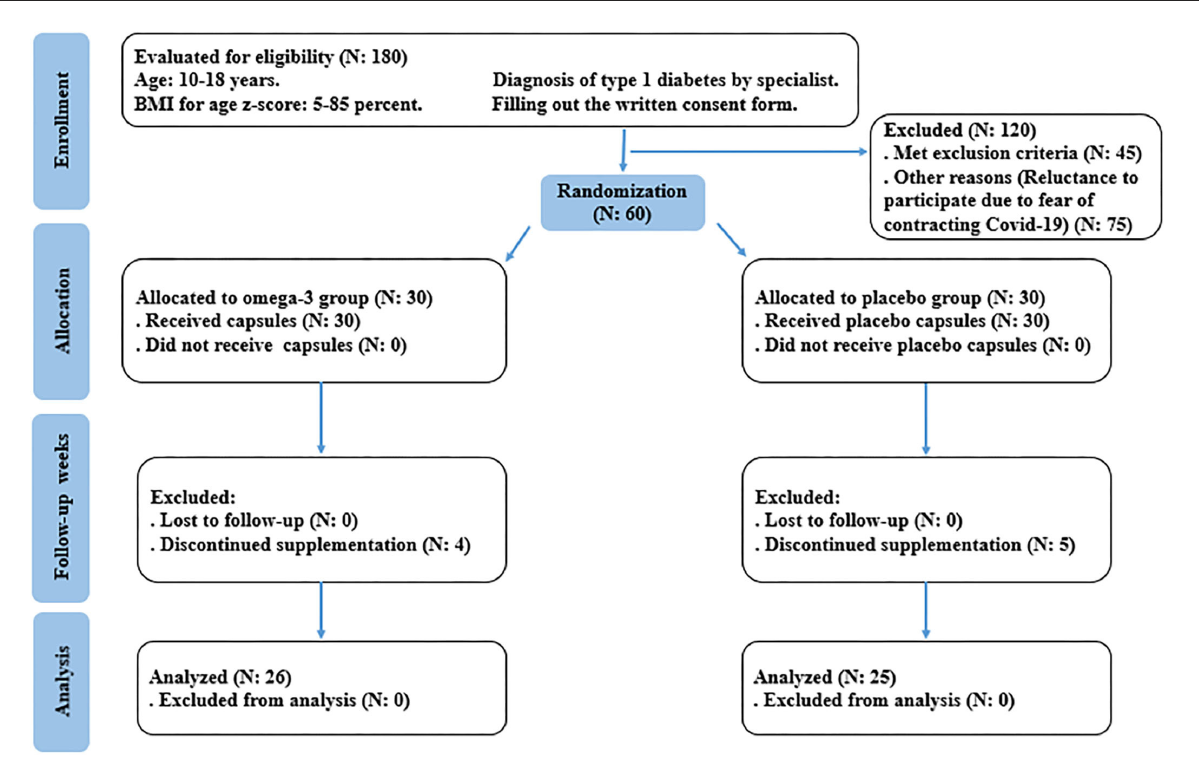
FIGURE1 Summary of study based on the consolidated standards of reporting trials (CONSORT) flow